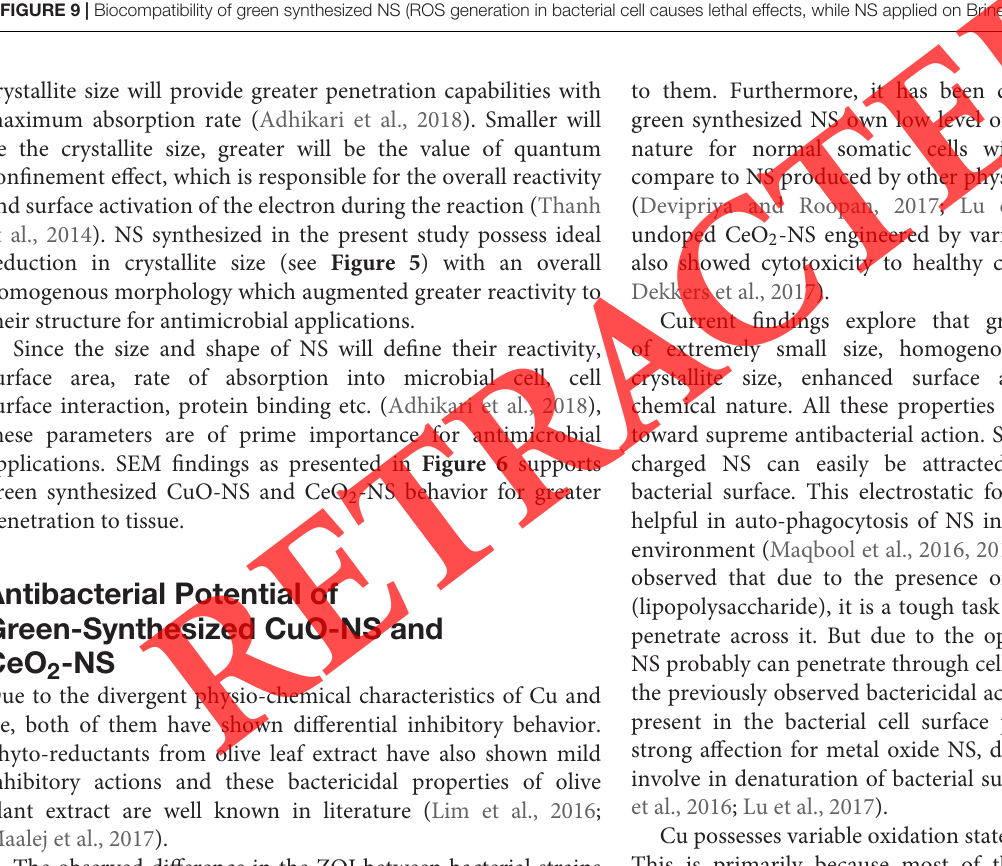
FIGURE 9 | Biocompatibility of green synthesized NS (ROS generation in bacterial cell causes lethal effects, while NS applied on Brine Shrimp are shown